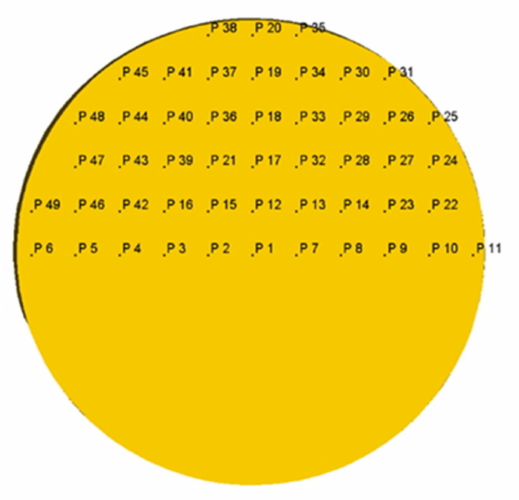
Figure 4. Changing of strain e ff ectiveness in the cross-section of billet at the stationary stage of two-high (1) and three-high (2) screw rolling.